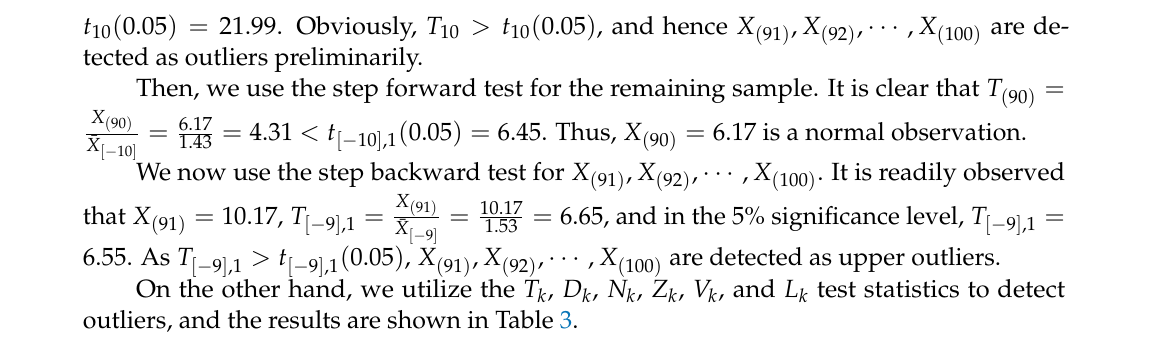
Table 3. The outlier detection results of alcohol-related mortality rates by using various tests. Number of Identified Number of Potentially Test Statistic Observations Misjudged Observations ITK 10 0 10